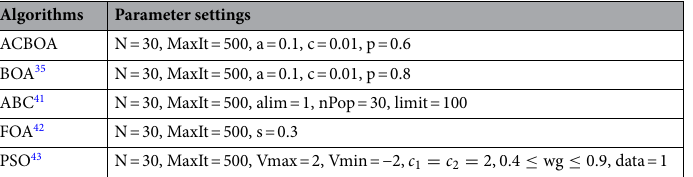
Table 1. Algorithm parameter setting.